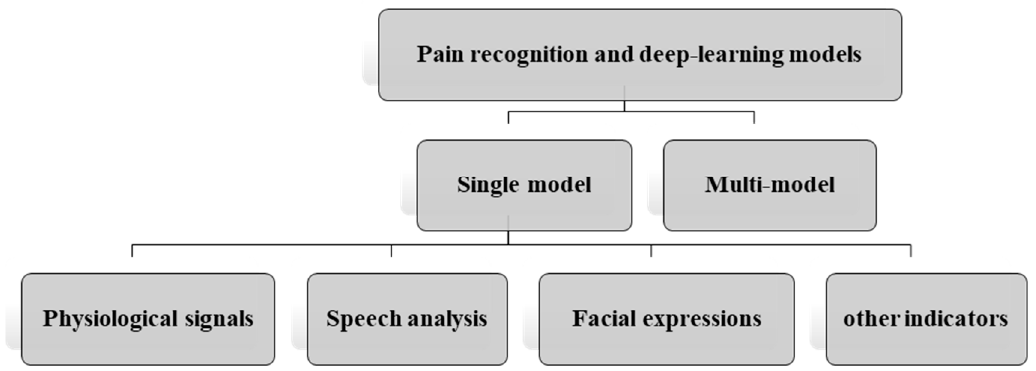
Figure 1. Categorization schema.